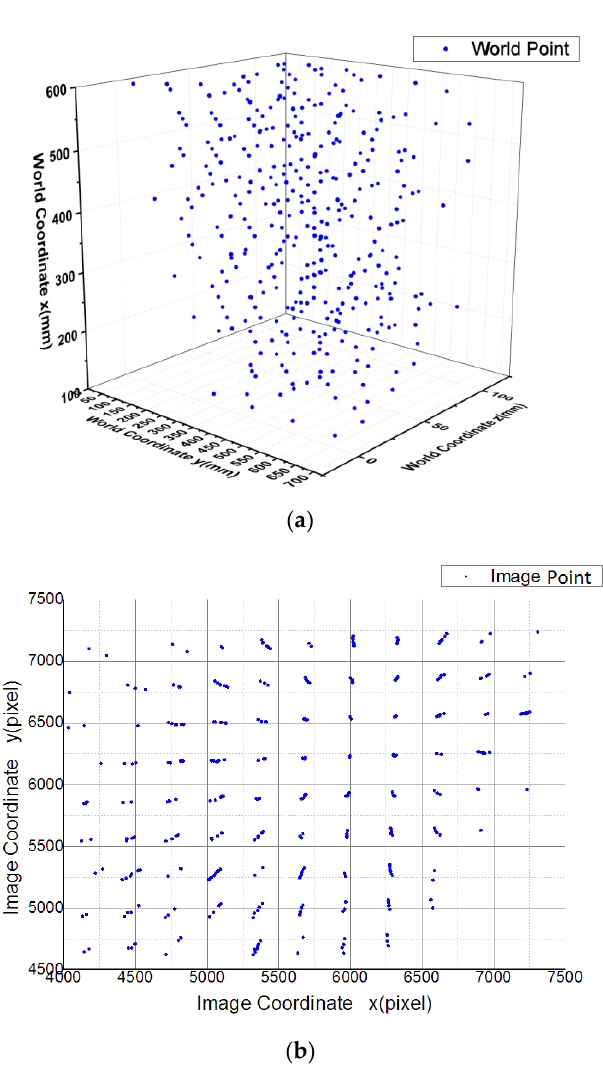
Figure 5. Calibration data set. ( a ) is the world coordinate of the calibration dataset. ( b ) is the image coordinate of the calibration dataset.